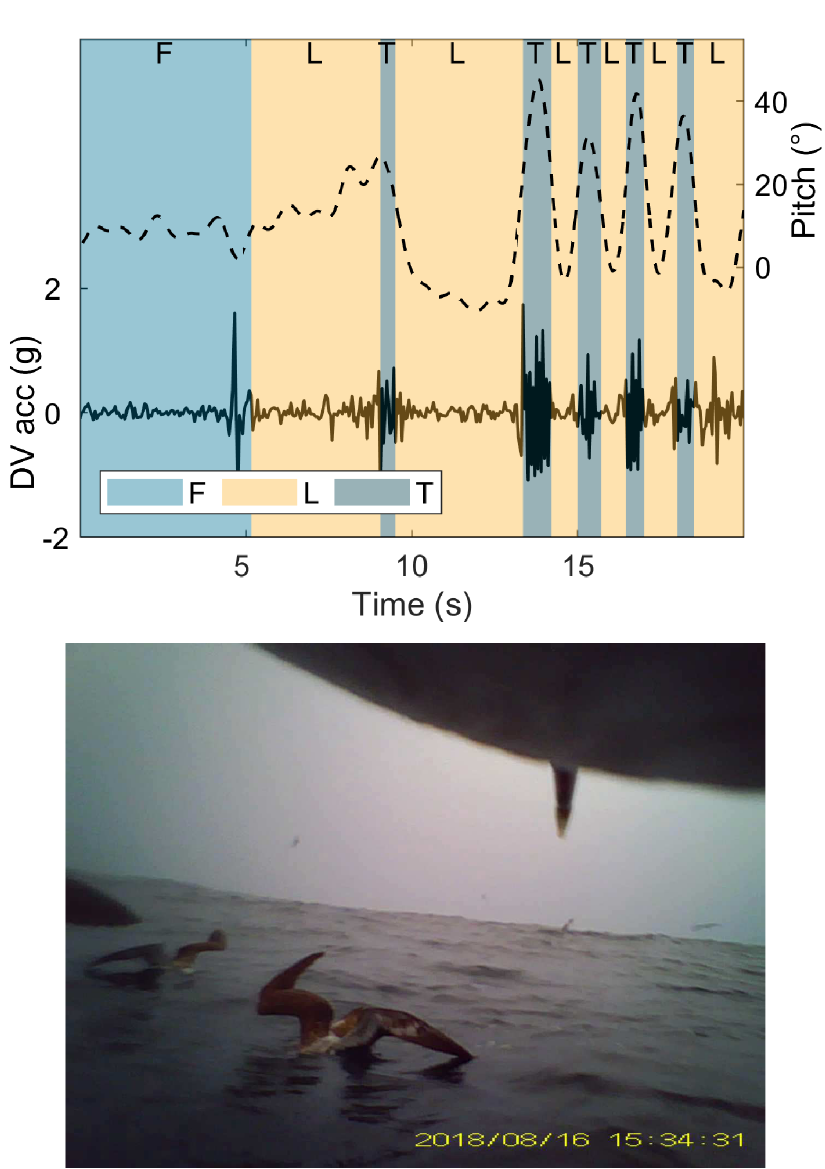
Fig 2. Surface seizing example. Dynamic dorsoventral acceleration (DV acc; solid line) and pitch (dashed line) during a transition from flight to surface seizing event, as recorded by video (top). The background is colour-coded depending on behaviour, flight (F), landing (L), and take-off (T), and each behaviour is labelled above. This foraging consisted of a series of short landings during which the tag was submerged separated by even shorter take-offs. The video-recordings captured some non-tagged birds performing foraging behaviours (bottom). In this example, a non-tagged conspecific clearly has its head submerged while sat on the water surface. the water surface was visible on the video footage as the birds ascended, indicating the birds fully submerging (Fig 3). Recordings of foraging behaviours in conspecifics showed that dur- ing surface seizing the shearwaters would submerge their heads under the water surface, as vis- ible both from the tagged animal and in a recorded conspecific (Fig 2). DVL-tagged individuals all performed surface seizing (mean landing duration ± standard deviation 1.5 ± 1.4s, mean take-off duration 0.6 ± 1.6s, mean total duration including inter-landing take-offs 23.1 ± 40.4s). Foraging dives following a plunge from the air and after an initial landing were